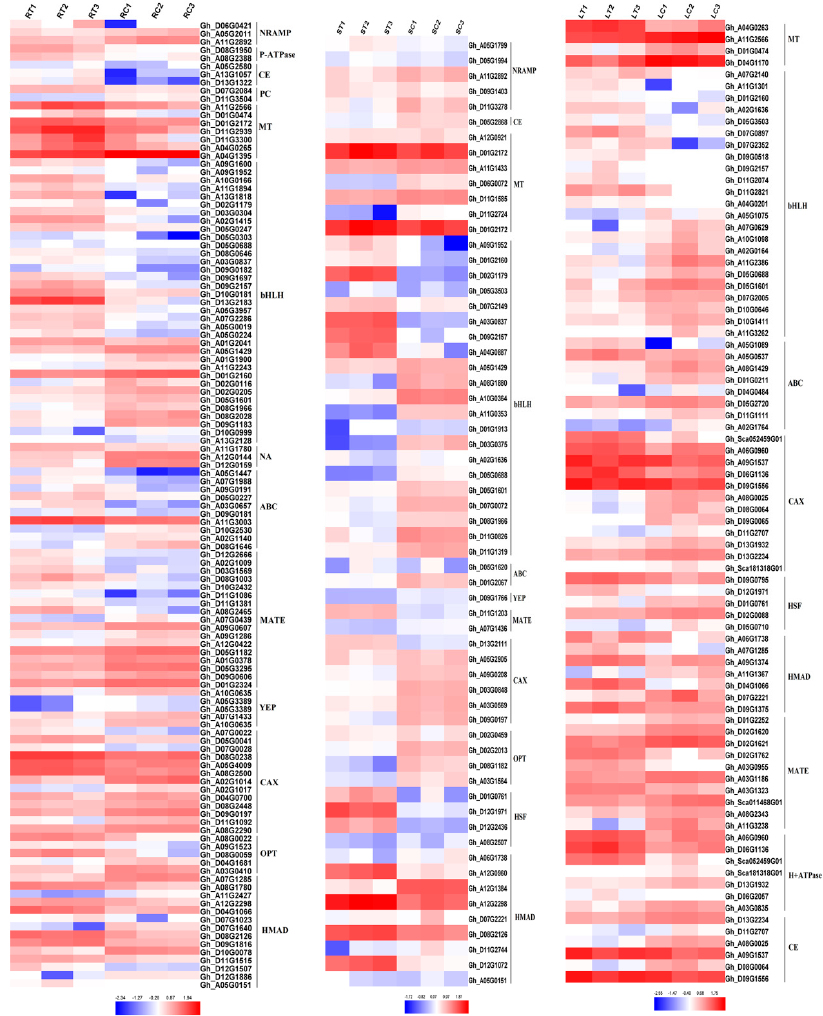
Figure 4. Metal transporters expressed in roots, stems and leaves under Cd stress. RT1: Root Cd treatment 1, RT2: Root Cd treatment 2, RT3: Root Cd treatment 3, RC1: Root water control 1, RC2: Root water control 2, RC3: Root water control 3, ST1: Stem Cd treatment 1, ST2: Stem Cd treatment 2, ST3: Stem Cd treatment 3, SC1: Stem water control 1, SC2: Stem water control 2, SC3: Stem water control 3, LT1: Leaf Cd treatment 1, LT2: Leaf Cd treatment 2, LT3: Leaf Cd treatment 3, LC1: Leaf water control 1, LC2: Leaf water control 2, LC3: Leaf water control 3. The fold-change ratios of the genes are indicated by the different colors. The red color represents the highest expression, the blue color represents the lowest expression. CE: cation efflux family, ABC: ATP-binding cassette transporter, CAX: calcium exchanger, NRAMP: natural resistance-associated macrophage protein, NA: nicotianamine, OPT: peptide transporter, PC: phytochelation, MT: metallothionein, MATE: multidrug resistance-associated protein, YEP: yellow stripe protein, bHLH: basic helix-loop-helix DNA-binding protein, HMAD: heavy metal transporter. HSF: heat shock factor.